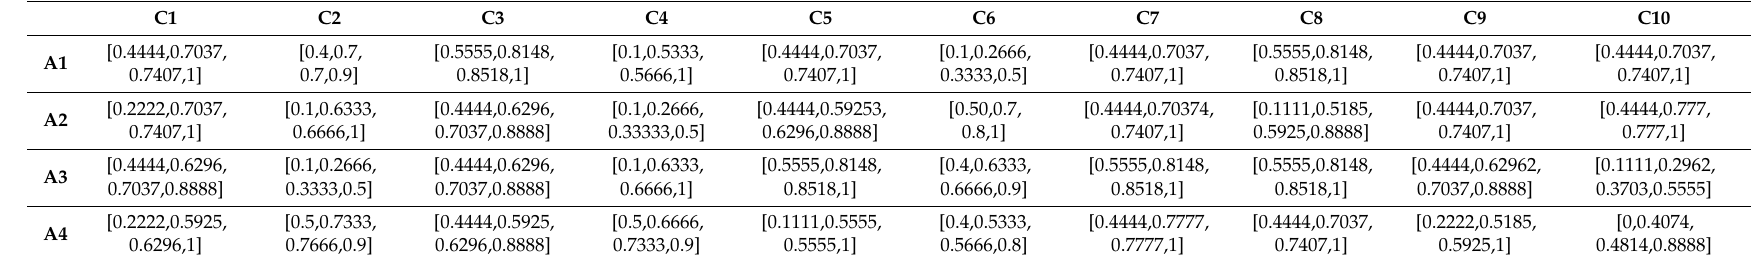
Table 9. Normalized aggregated fuzzy decision matrix.